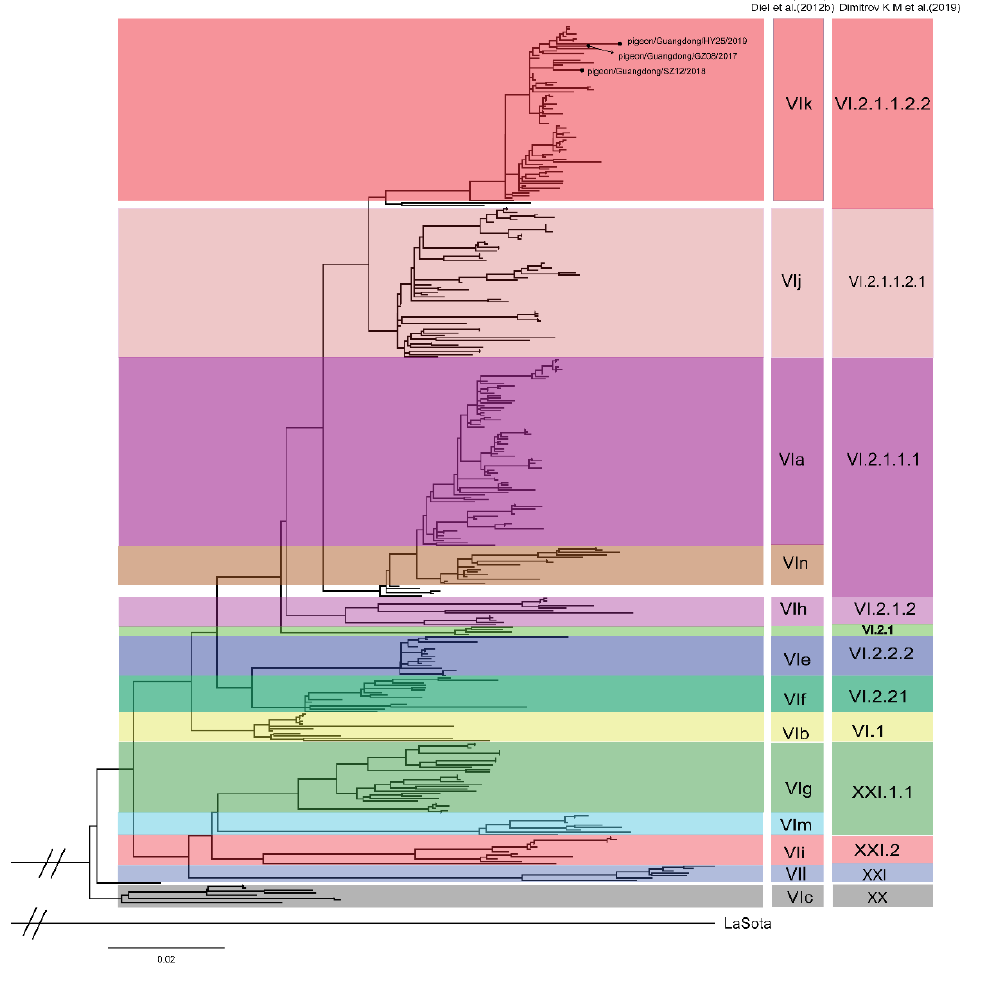
Figure 1. The maximum likelihood tree of PPMV-1 strains. The tree was reconstructed based on the complete F gene (1–1662 nt) sequence using the IQ-TREE software, implemented by the GTR + F + I + G4 model with 1000 bootstrap replicates, using the genotype II NDV strain LaSota as the outgroup.